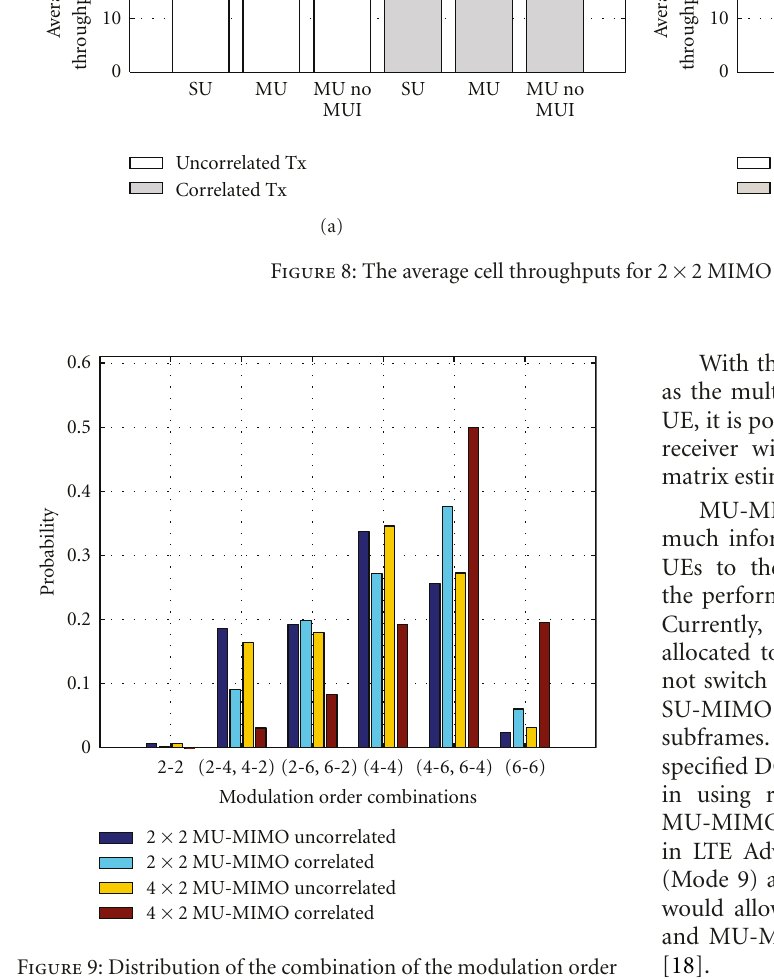
Figure 9: Distribution of the combination of the modulation order observed at scheduled MU